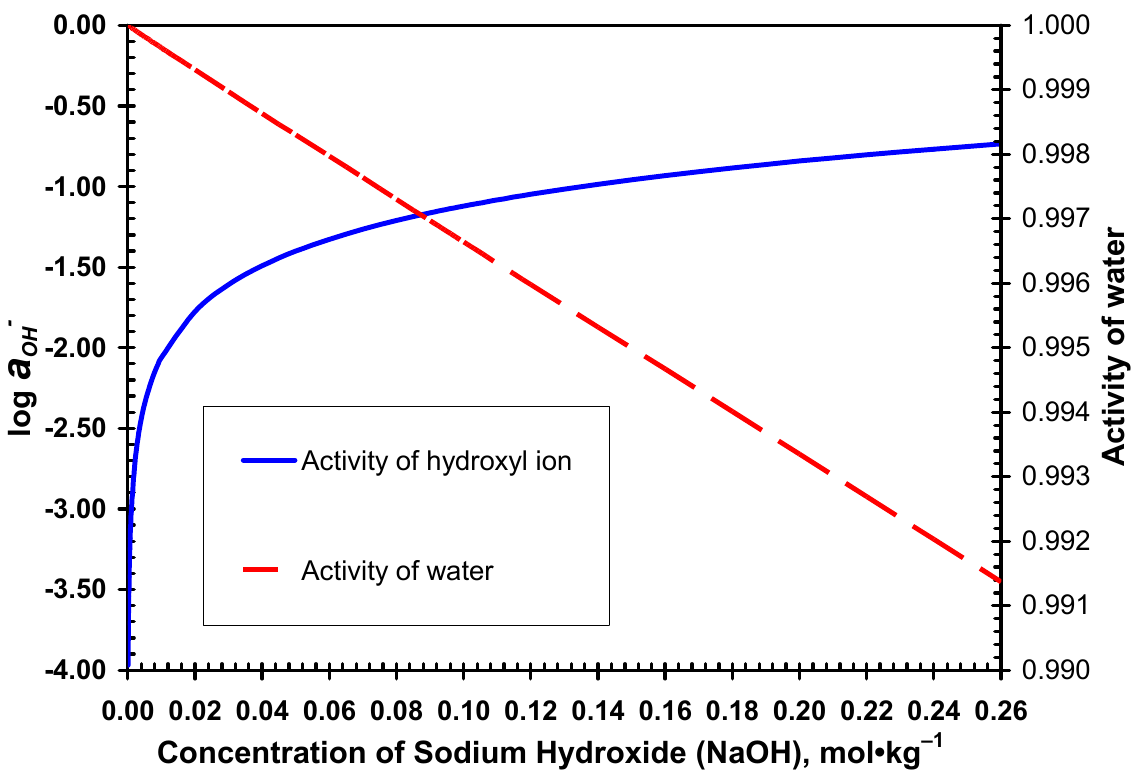
Figure 11. Predicted activities of the hydroxyl ion and water for sodium hydroxide (NaOH) solutions relevant to desulphurization of lead sulfate in alkaline solutions at 25 ◦ C. Activities of the hydroxyl ion and water of sodium hydroxide solutions are calculated according to the thermodynamic parameters from Xiong et al. [15].